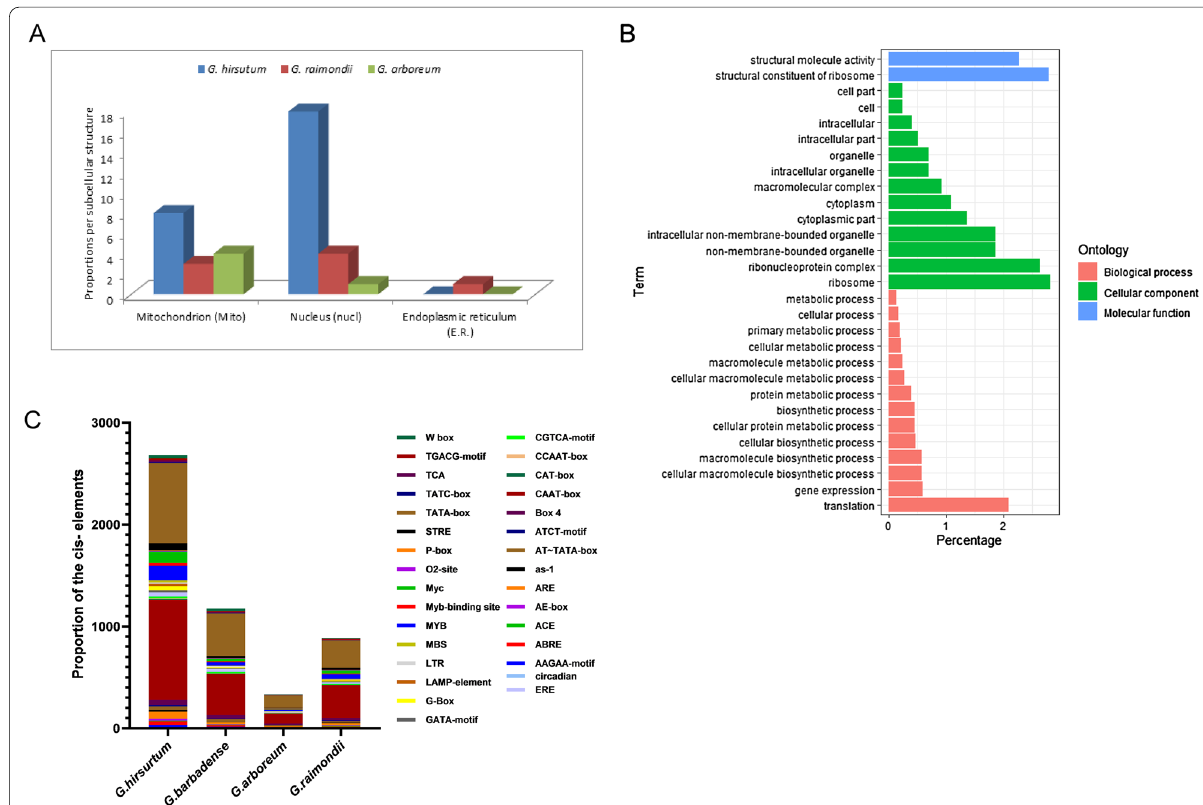
Fig. 5 Subcellular localization, GO analysis and cis -regulatory element. A Subcellular localization of RPL14B genes in G. hirsutum , G. raimondii,